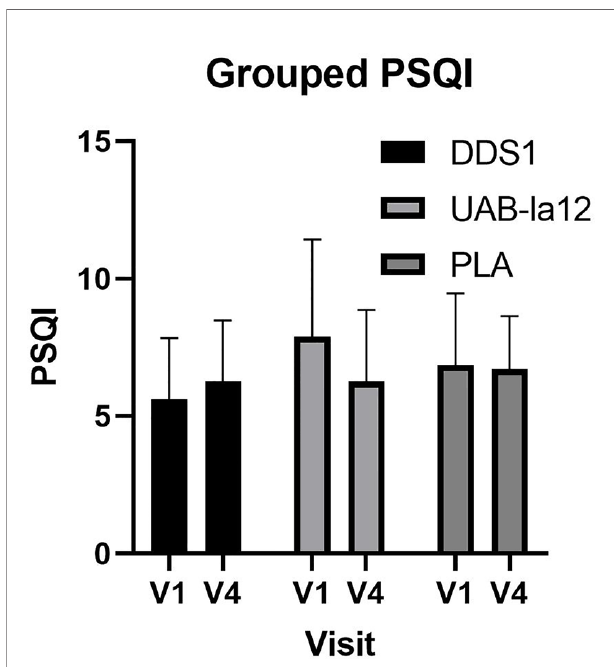
FIGURE 3 | Changes in the PSQI from pre-supplementation (V1) to the end of supplementation (V4). A statistical trend for a 22% decrease in the UABla-12 group was observed (p=0.063). Data is median and 95% con fi dence